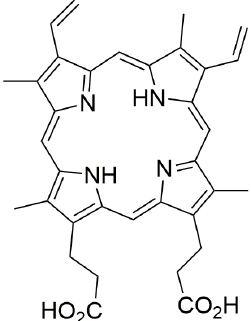
Figure 1 - Structure of Protoporphyrin